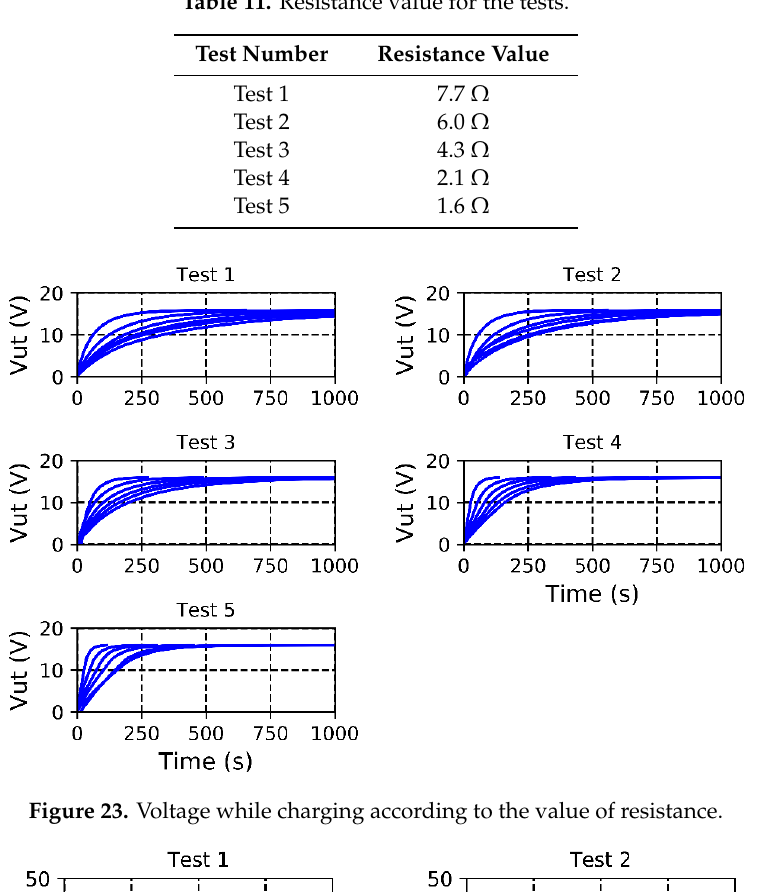
Figure 23. Voltage while charging according to the value of resistance.